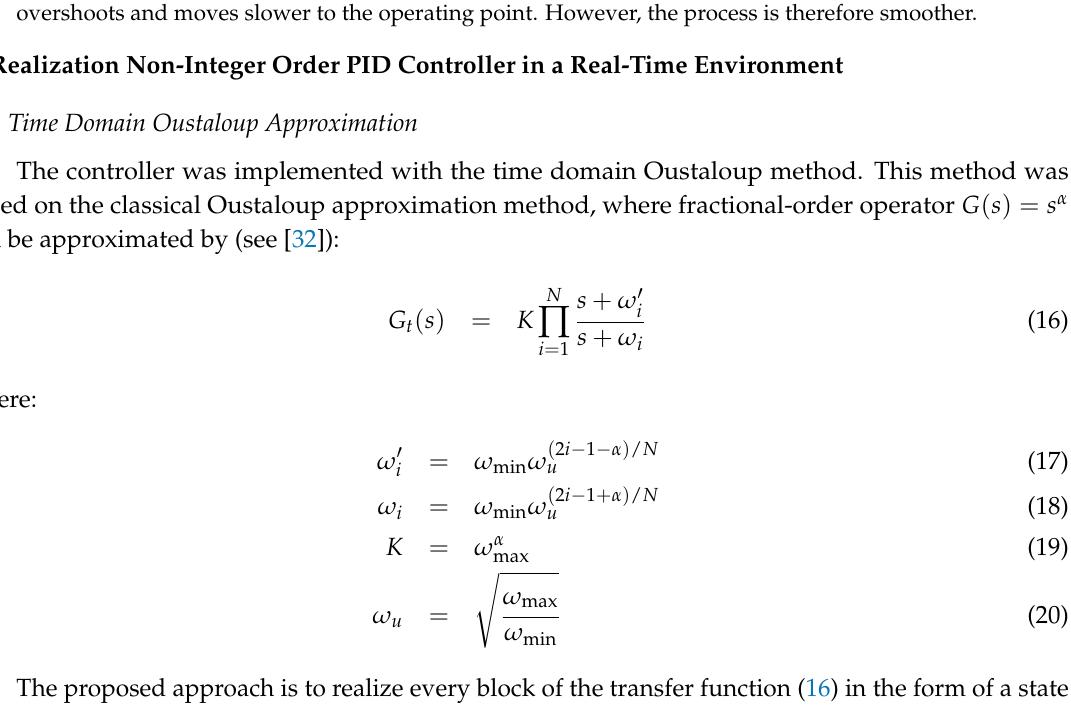
Figure 4. Result of the tuning system using simulated annealing for differing quality indicators. As can be seen in the case of Figure 4a,c, the controller allows the system to slightly overshoot. In these cases, the system also reaches the set point the fastest. In other cases, the system does not have any overshoots and moves slower to the operating point. However, the process is therefore